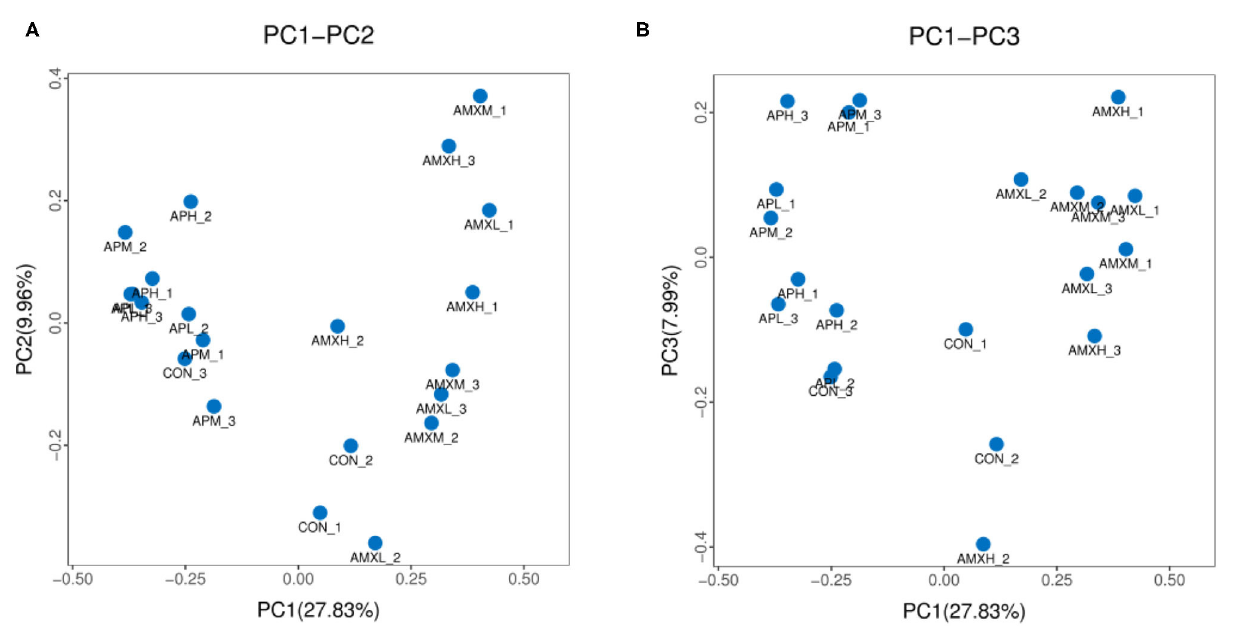
Frontiers in Veterinary Science |